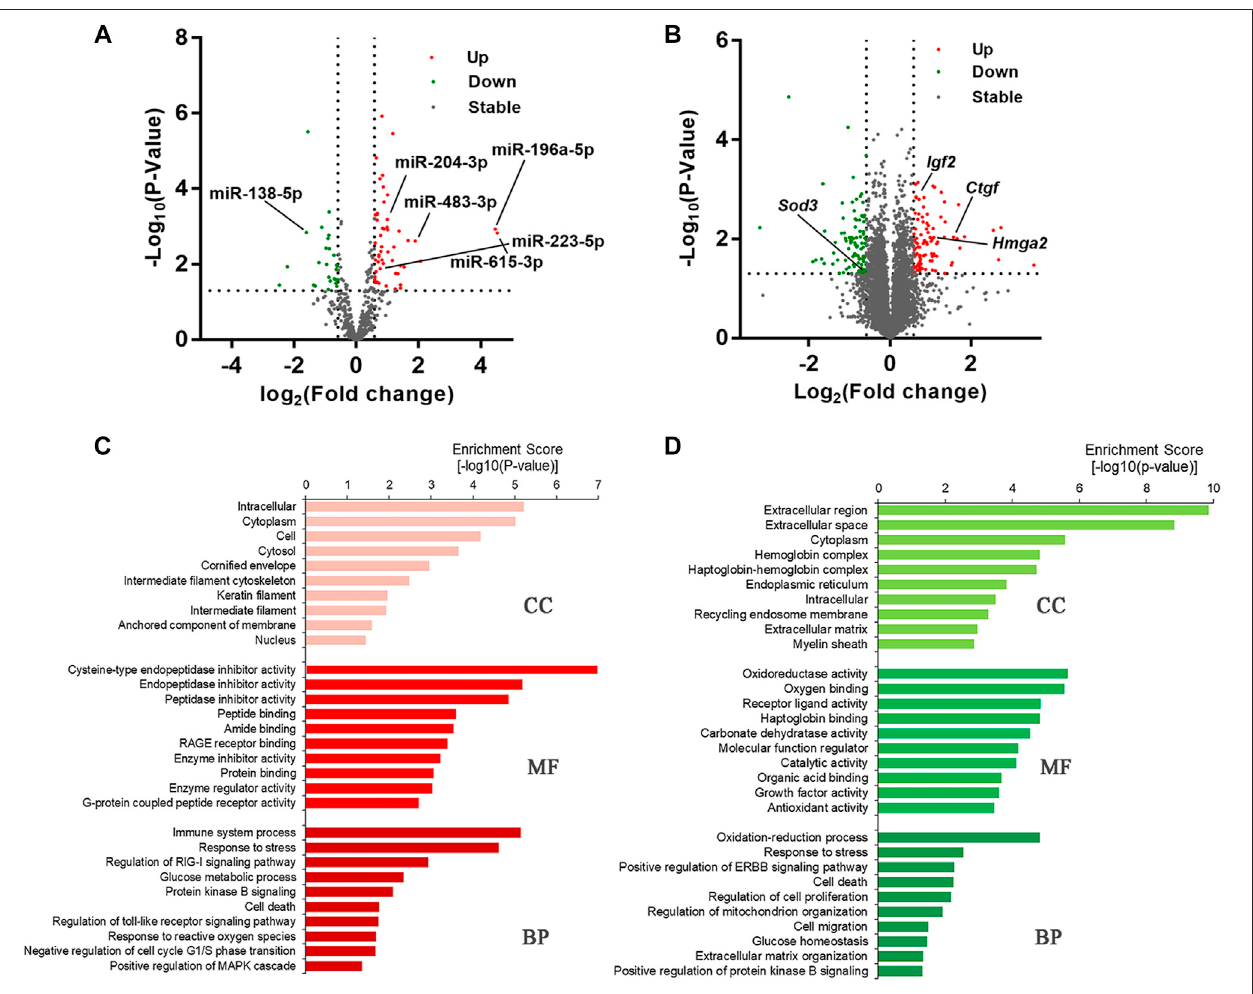
FIGURE 2 | T1DM alters the transcriptome composition of regenerative corneal epithelium. (A) DEmiRNAs and (B) DEmRNAs are illustrated by volcano plots. (C) GeneOntology (GO) enrichmentanalysisrevealed the cellular component (CC), biological processes (BP)and molecularfunctions (MF) in which upregulated DEmRNAs and (D) downregulated DEmRNAs are signi fi cantly